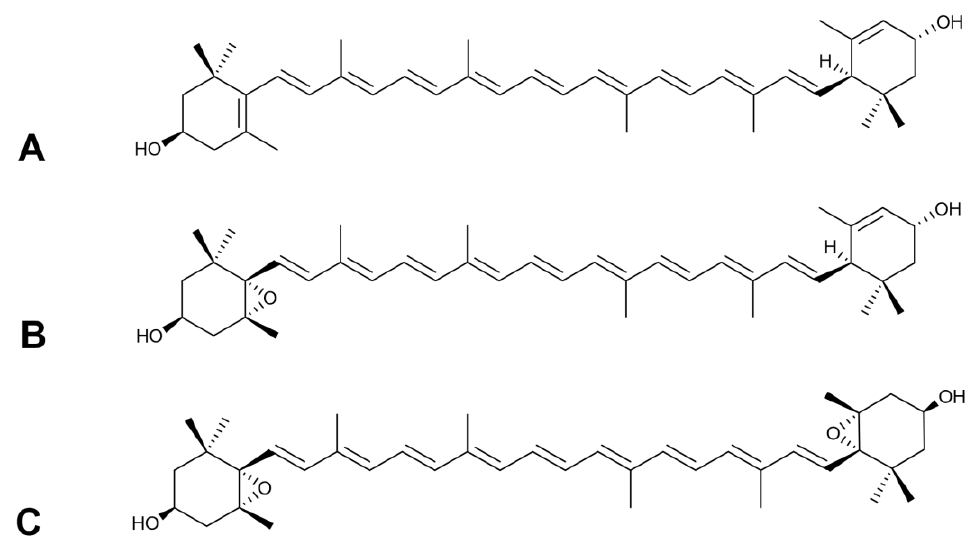
Figure 3. The most characteristic carotenoids of Meliloti herba. ( A ) (all- E )-lutein. ( B ) (all- E )-lutein 5,6-epoxide. ( C ) (all- E )- violaxanthin.